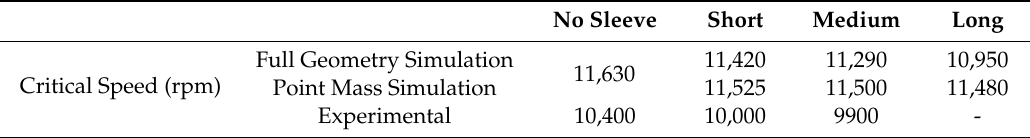
Figure 7. Campbell diagram for the full geometry finite element model. Inset shows natural frequencies and rotational velocity close to critical speeds. Table 4. Summary of shaft critical speeds.